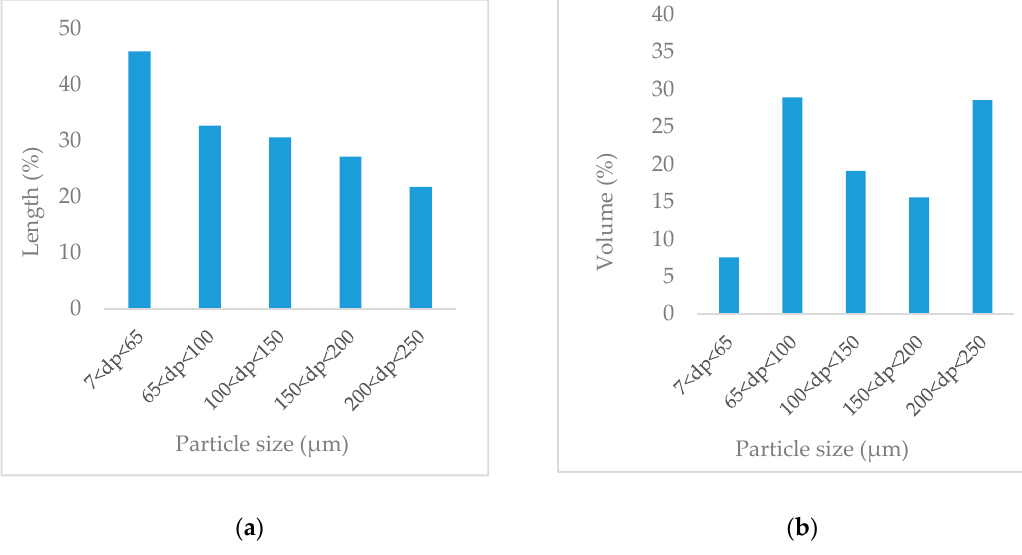
Figure 1. ( a ) Length-based particle size distribution, and ( b ) volume-based particle size distribution of DFH particles, as measured by the EyeTech instrument.